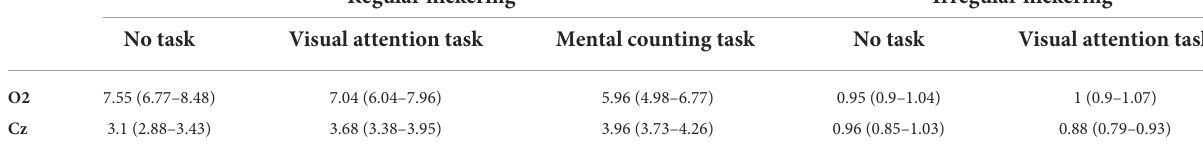
TABLE 1 Median SNR and 95% confidence interval for each stimulation condition at two representative electrodes. Regular